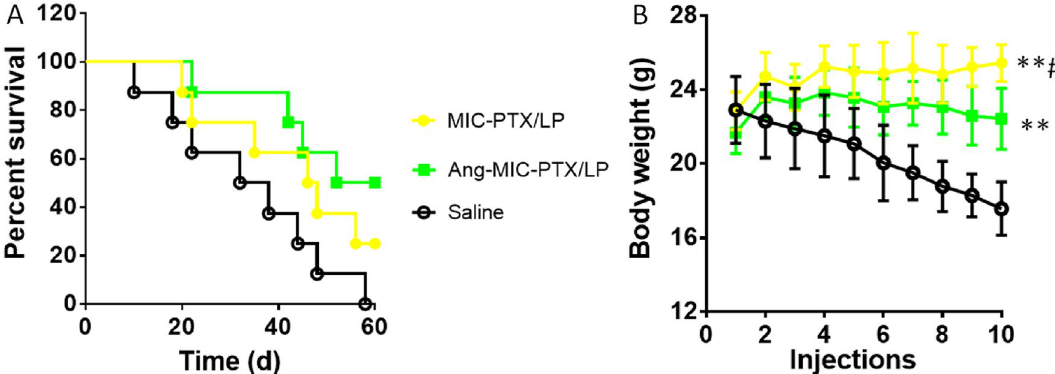
Figure 6. Anti-tumor efficacy of Ang-MIC-PTX/LP. ( A ) Survival curves (n = 8) and ( B ) body weight of tumor-bearing mice treated with ten cycles of different formulations at 3, 6, 9, 12, 15, 18, 21, 24, 27 and 30 days after Skbr-3 cells inoculation. The dose of PTX and LPT was 2.5 mg/kg and 5 mg/kg, respectively.** # P < 0.05, ** P < 0.01, compared with saline.